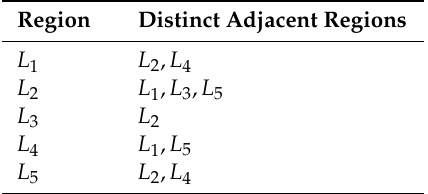
Table 1. Partition of input regions and distinct adjacent